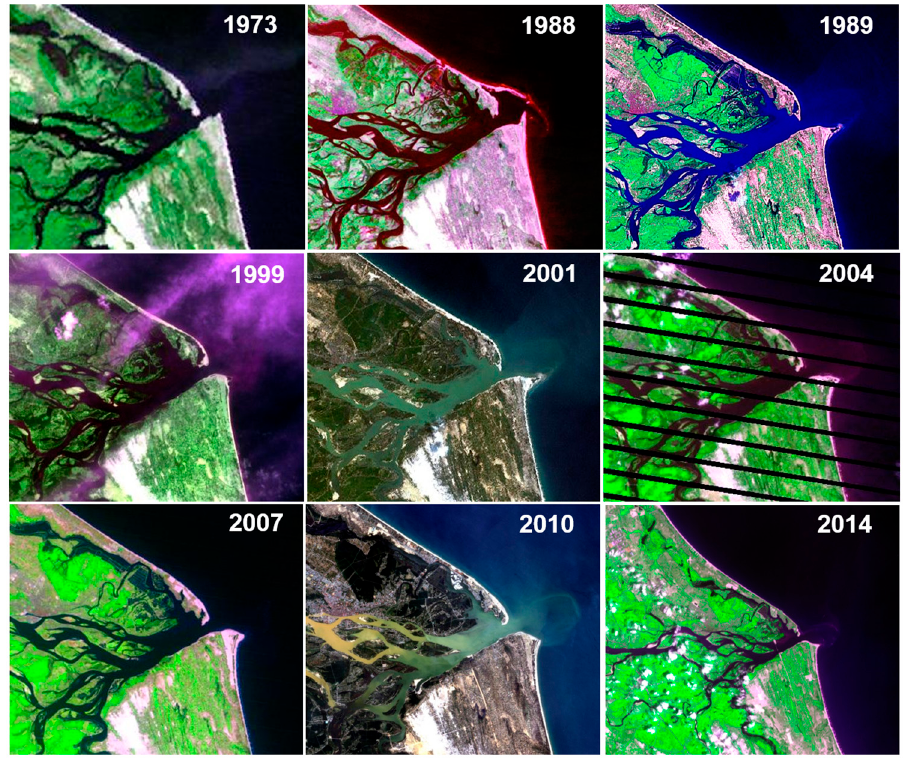
Figure 2. Characteristics of the Cua Dai estuary morphology from multi-temporal and spatial satellite images in the selected years.